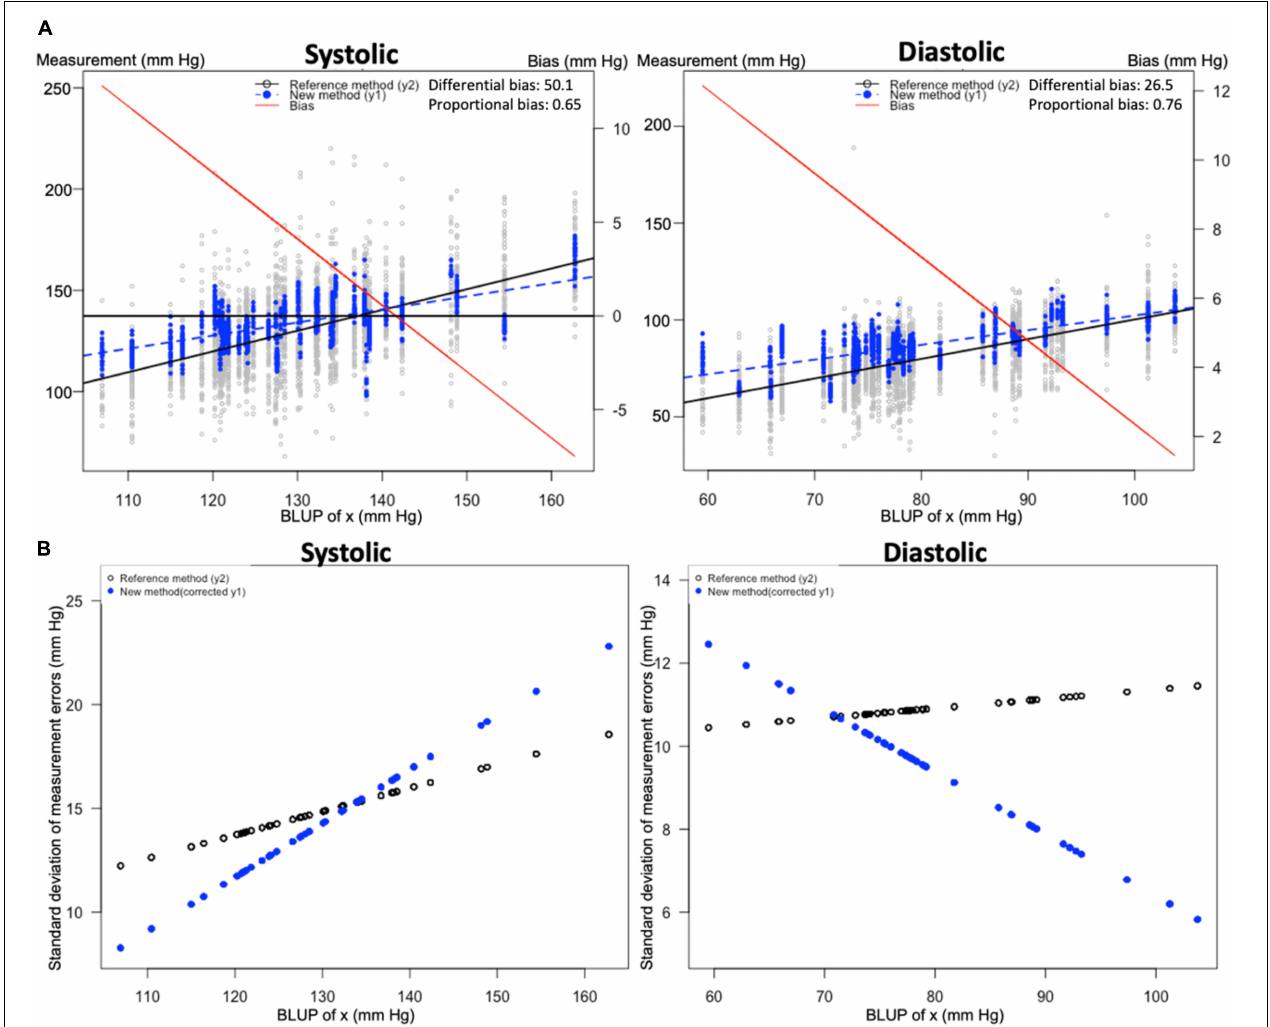
FIGURE 1 | Bias and precision plots according to Taffé method. Figures were constructed according to the Taffé method. (A) Bias plots for systolic and diastolic blood pressure (BP). The x -axis indicates the best linear unbiased prediction (BLUP) or true value of BP. Smartwatch measurements (blue dashed lines) are compared to 24-h BP measurements (solid black line); both values are read from the leftmost y -axis. The bias (difference of smartwatch measurement compared to the 24-h BP measurement) is depicted as a solid red line; the value of bias is read from the rightmost y -axis. (B) Precision plots for systolic and diastolic blood pressure (BP). The x -axis indicates the best linear unbiased prediction (BLUP) or true value of BP. The standard deviation of measurement errors for both measurements are depicted with the 24-h BP measurement depicted in black and the smartwatch method depicted in